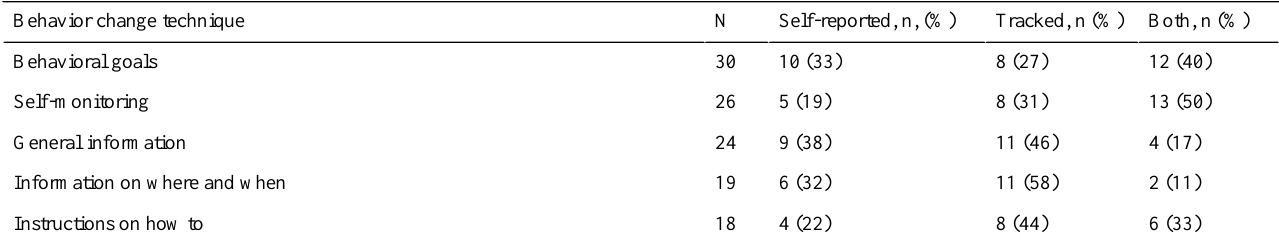
Both, n (%)Tracked, n (%)Self-reported, n, (%)NBehavior change technique